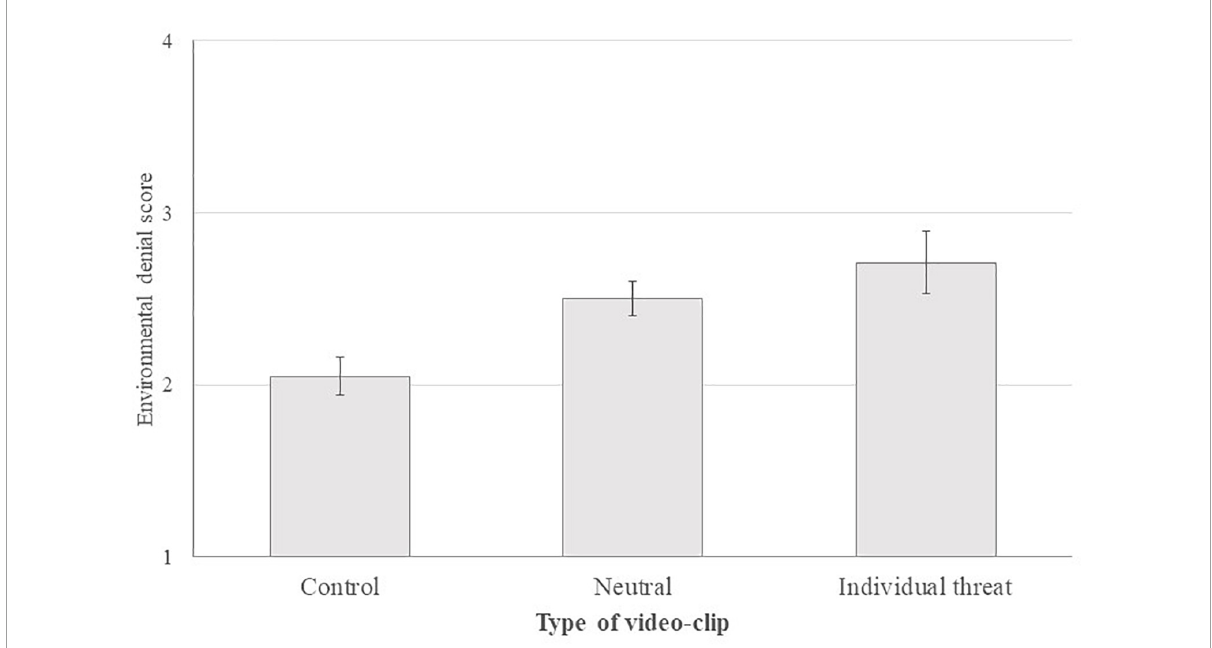
FIGURE2 Environmental denial score depending on video-clip type. Errors bars indicate the standard